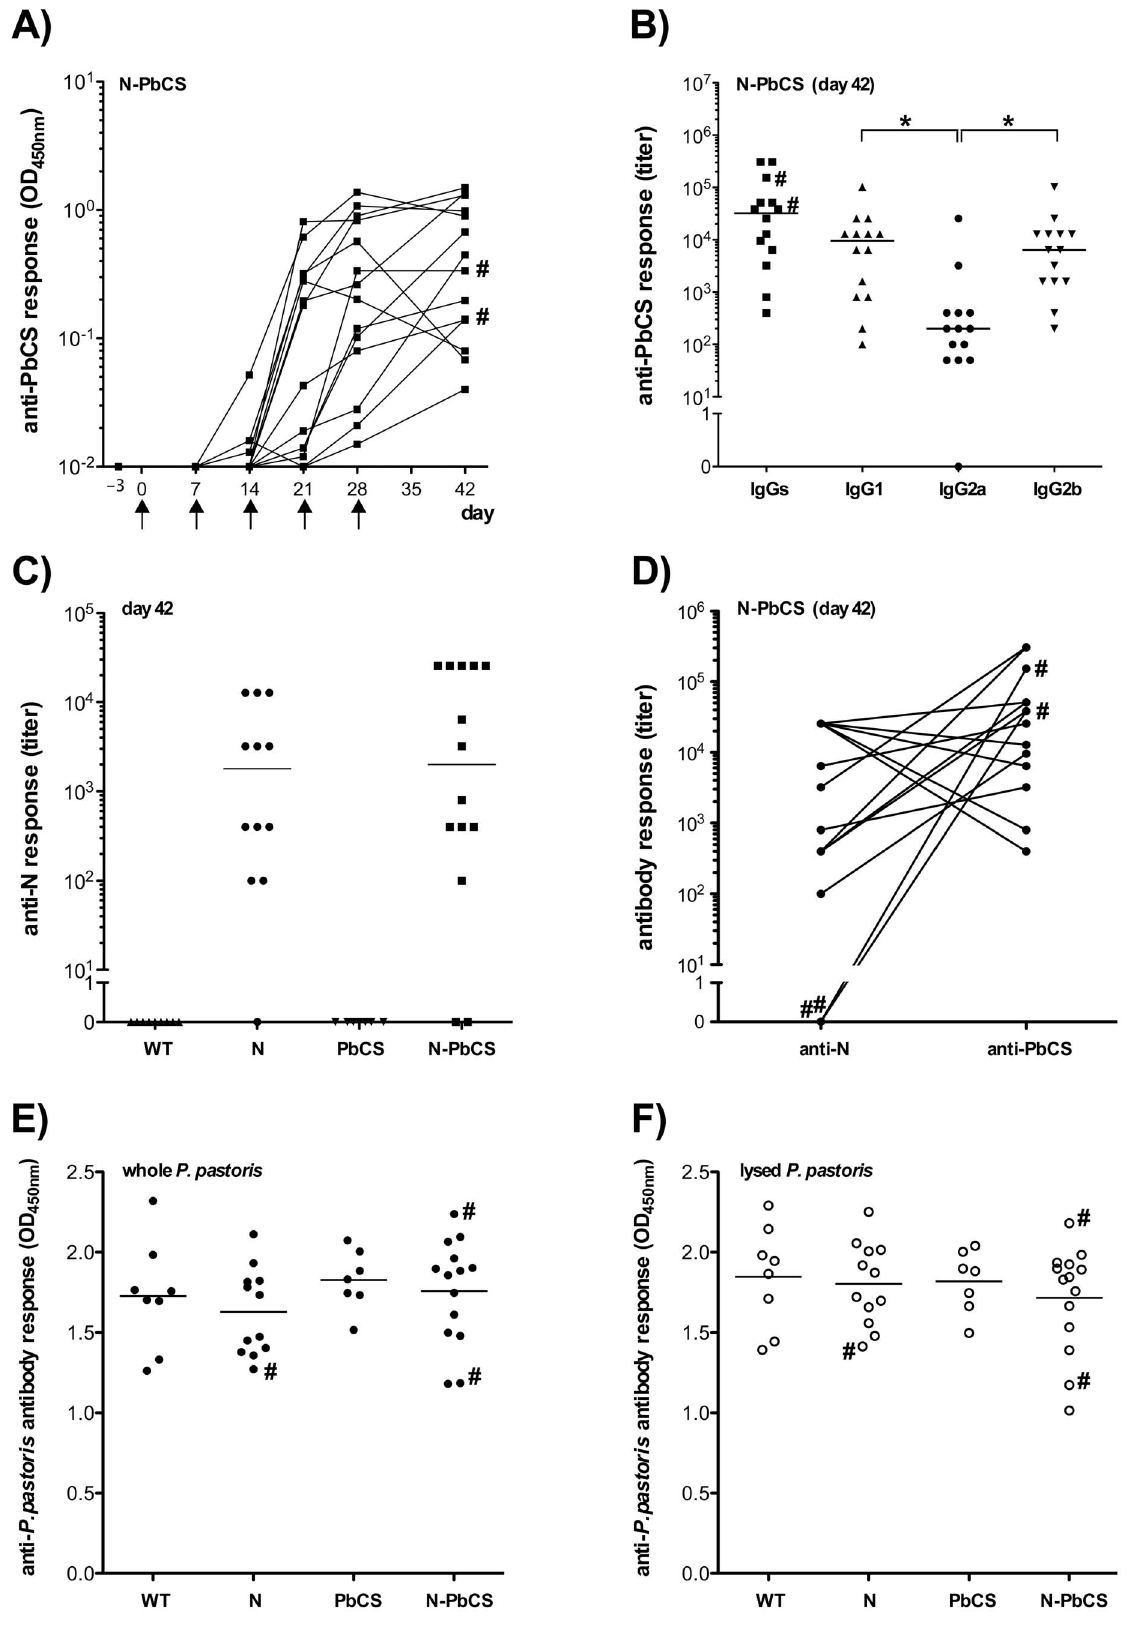
Figure 7. Humoral responses elicited in mice after immunization. ( A ) Kinetics of anti-PbCS IgG responses in mice immunized with N-PbCS yeasts. OD 450 nm are expressed in log 10 scale. Black arrows indicate immunization schedule. ( B ) Isotyping of humoral IgG responses at day 42 in mice